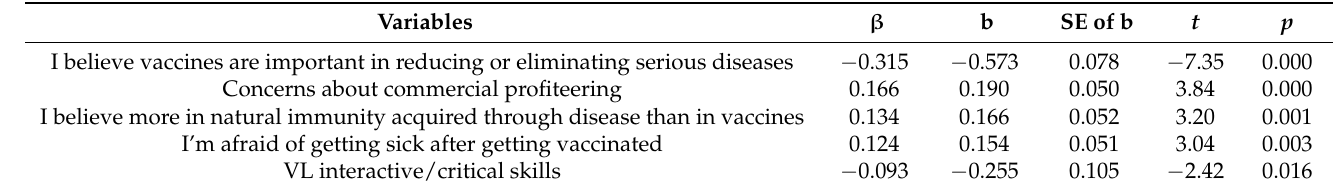
Table 8. Regression model for Variable Mistrust of vaccine